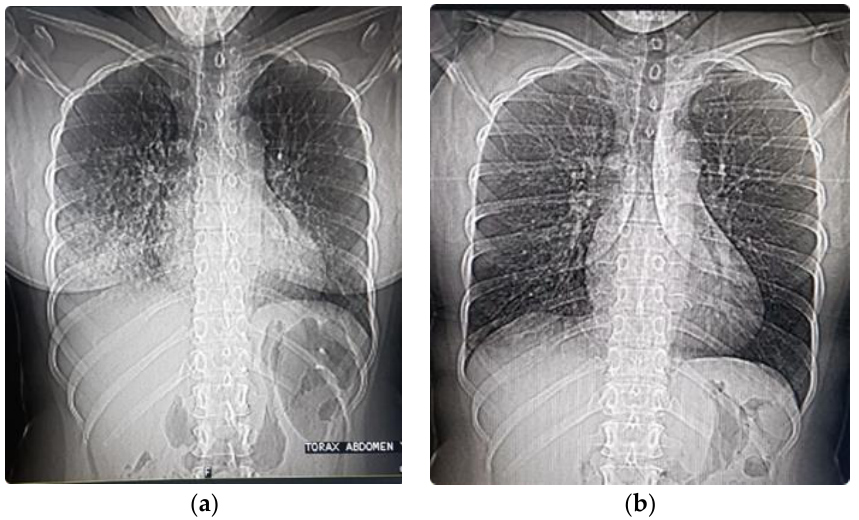
Figure 6. Thorax and abdominal X-rays performed during the CAT scan of a patient with HAPE at 3500 m. ( a ) Four days after arrival at high altitude. Note the distension of gases HAGE; ( b ) Two days later following the treatment described in our article